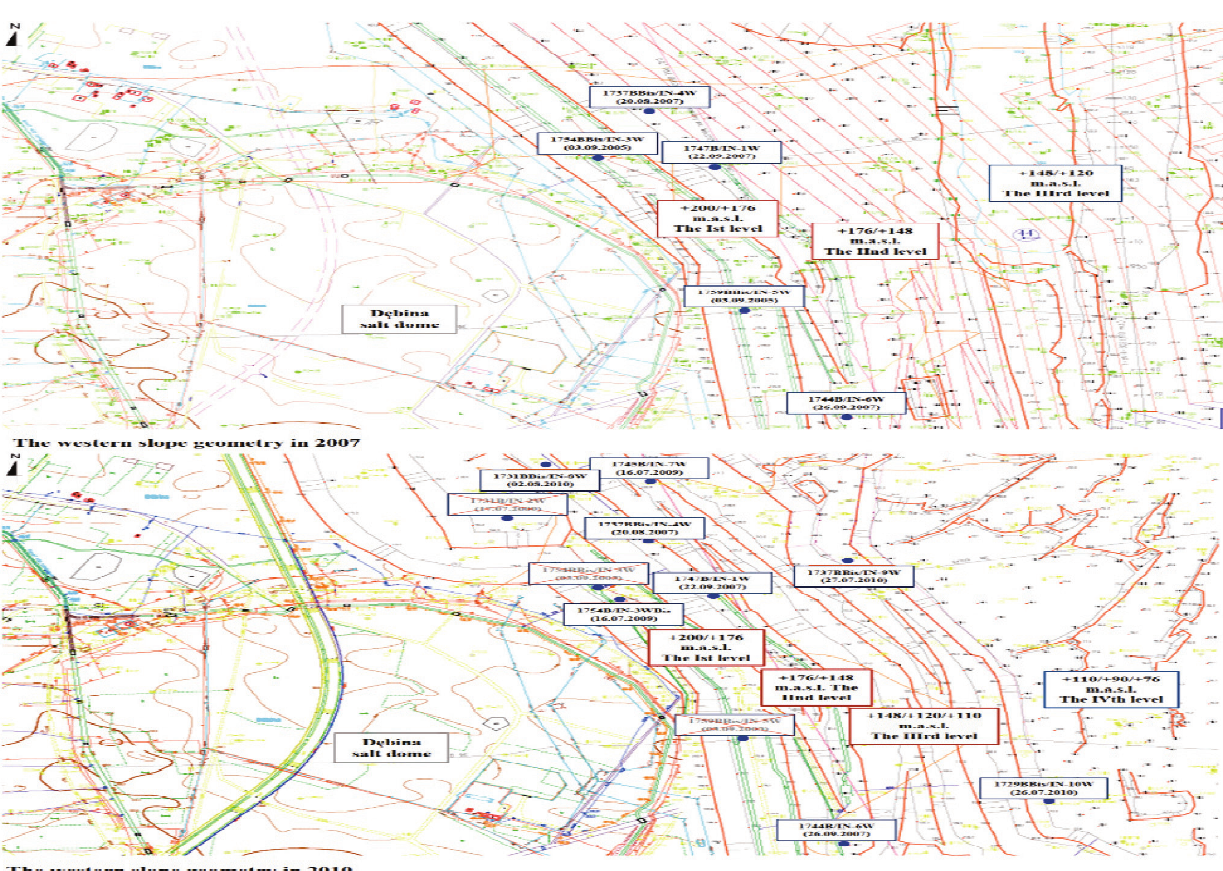
Fig. 8. The exploitation progress and western slope geometry changes between 2007 and 2010 (based on